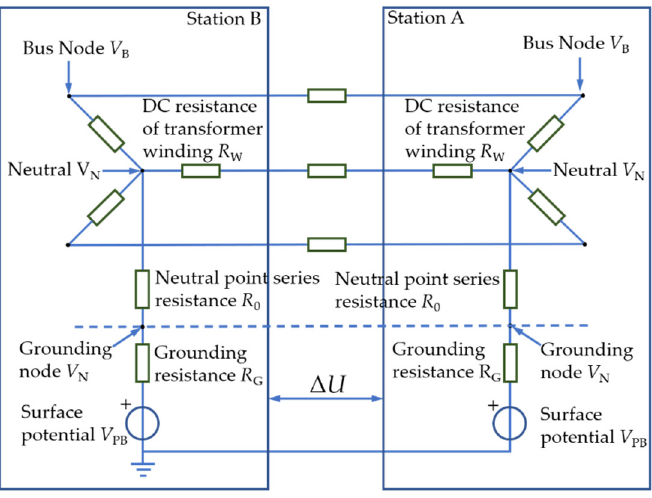
Figure 3. DC path model of power grid under DC bias.